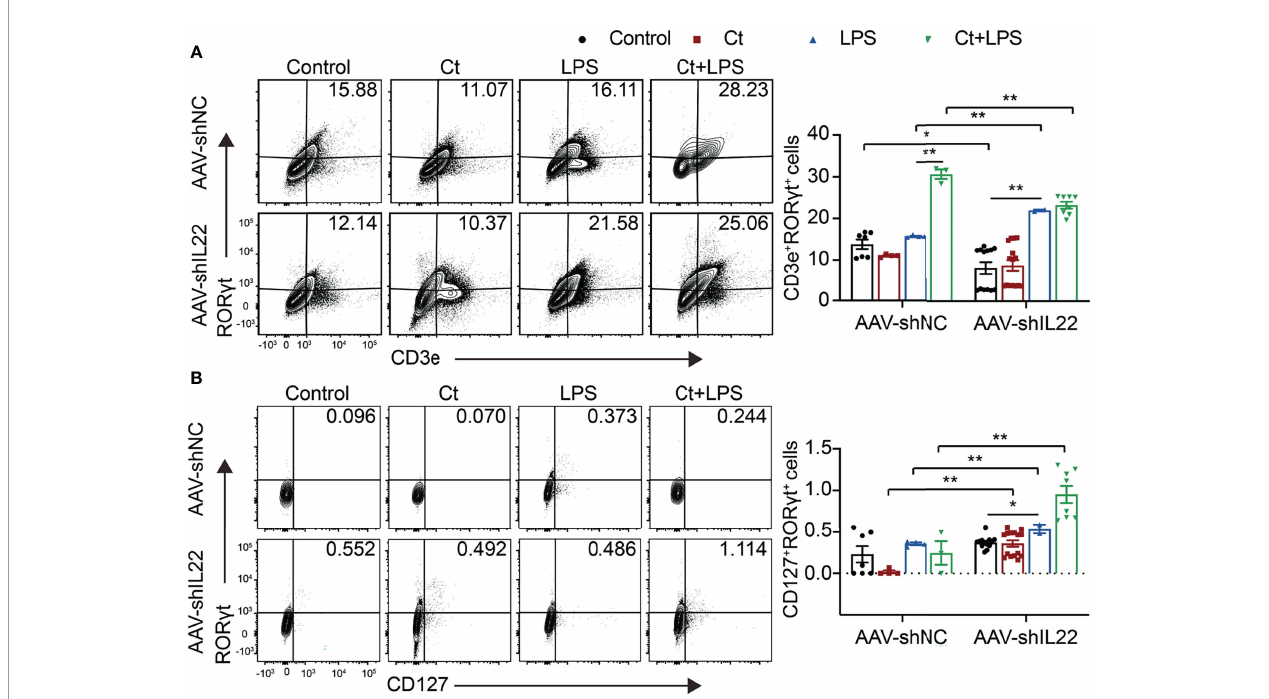
FIGURE 5 | Ct stimulates Th17 cells rather than ILC3s in the ileum. Flow cytometric analyses were conducted on 8-colour FACS Verse and three panels were used to analyzing the intestinal immune cells. The single cells were fi rst gated on SSC-A vs FSC-A and FSC-A vs FSC-H, and then CD45 + FVS780 - cells (CD45 + Live + cells) were gated out. CD3e + ROR g t + cells were gated out from CD45 + CD3e - cells. CD45 + CD3e - cells were gated out from CD45 + FVS780 - cells and CD127 + ROR g t + cells were gated out from CD45 + CD3e - cells. (A) Proportions of Th17 cells (CD45 + CD3e + ROR g t + cells). (B) Proportions of ILC3s (CD45 + CD3e - CD127 + ROR g t + ). Each point presented a mouse. Data were presented as mean ± SEM. The signi fi cant difference was analyzed by two-way unpaired t-tests. * P < 0.05, ** P <